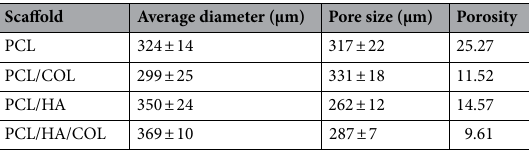
Table 1. The properties of the scaffolds.